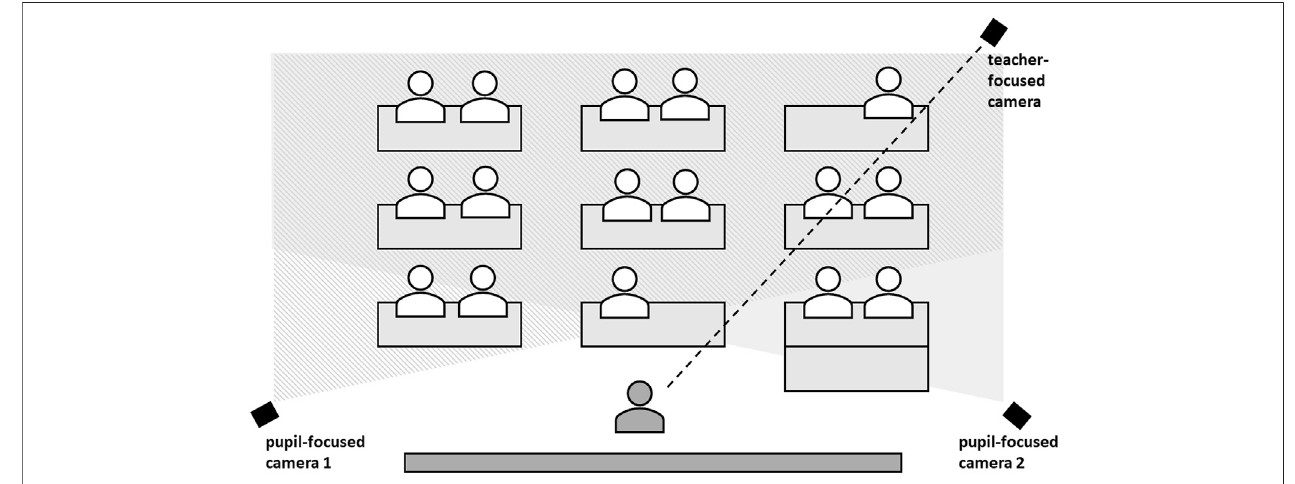
FIGURE 1 | Camera